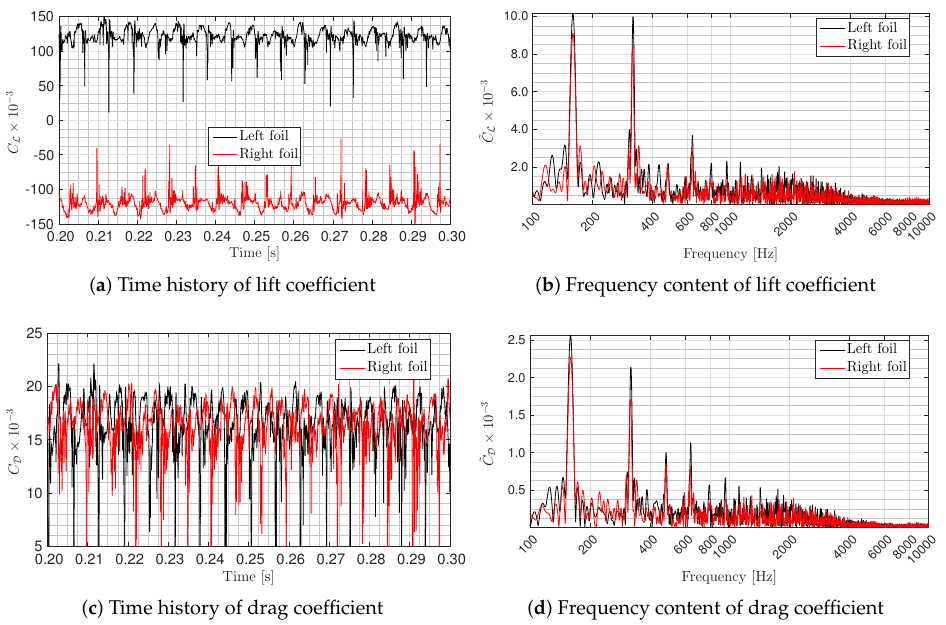
Figure 12. Time history and frequency content of the lift and drag coefficients. Fine grid, σ = 1.27,